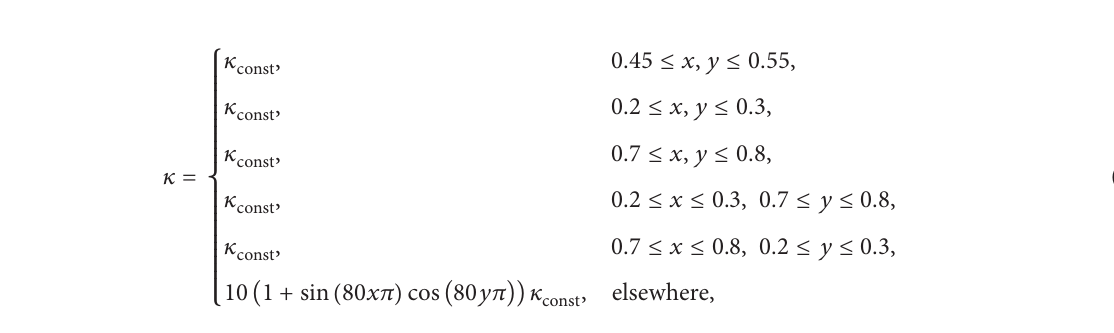
⃗𝐺 = (2, 0) ms −2 const